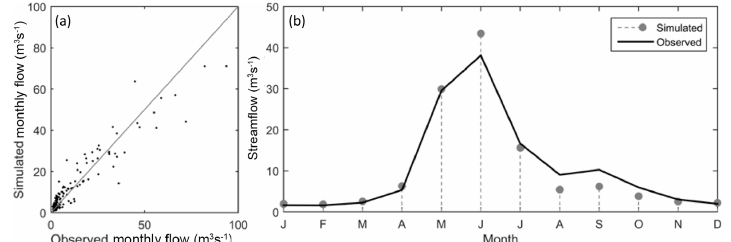
Figure 10. (a) Scatter plot of simulated versus observed monthly streamflows and (b) the observed versus simulated average monthly streamflows for the simulation